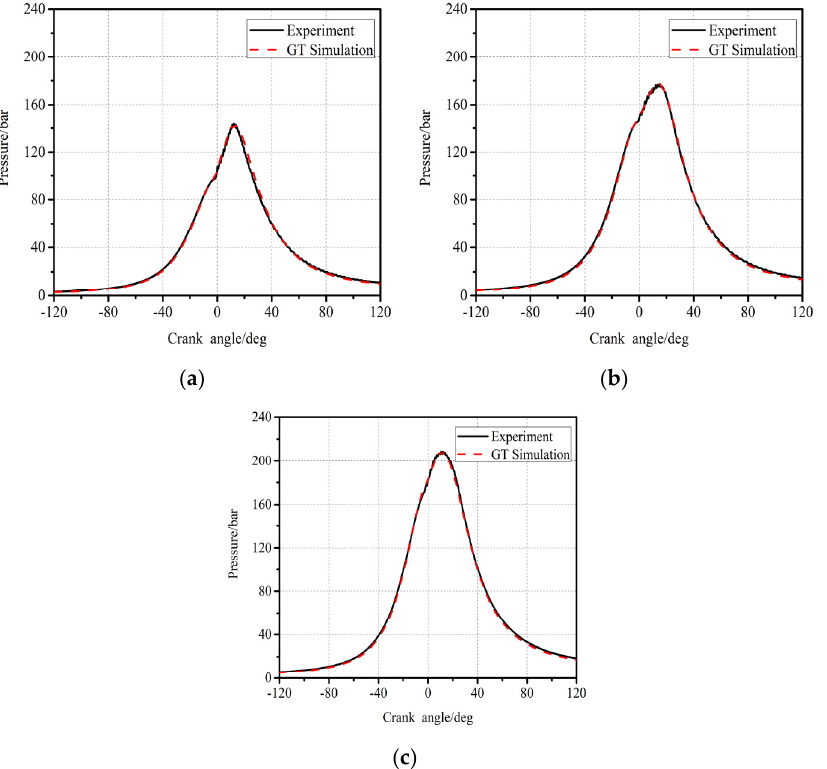
Figure 3. Comparison between experimental and GT simulation results of in-cylinder pressures: ( a ) 50% load; ( b ) 75% load; ( c ) 100% load.